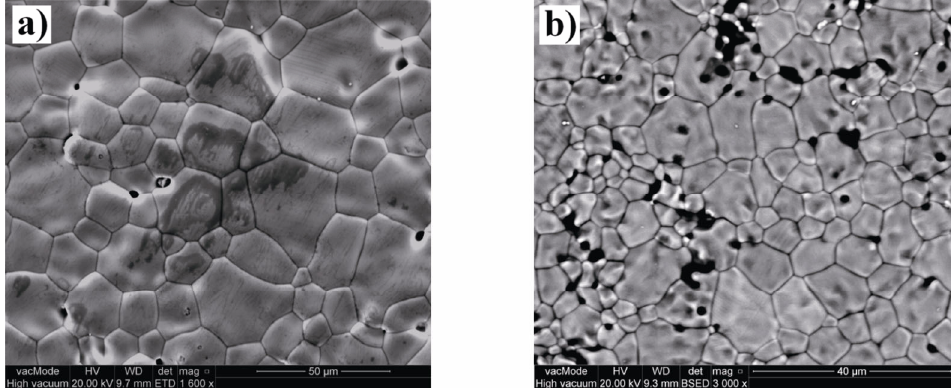
Figure 6 displays the morphology of the